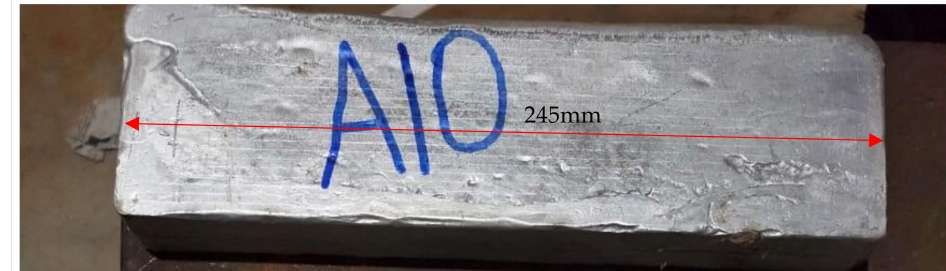
Figure 20. Fabricated sample.